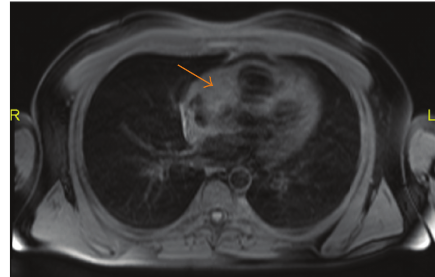
Figure 11: A 35-year-old male with fat-saturated T1-weighted image showing a lesion abutting the right atrium that is isointense to the surrounding muscle.